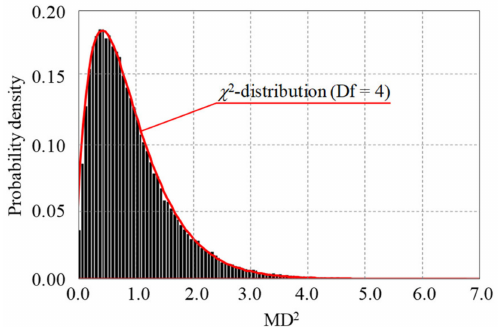
Figure 3. Probability density distribution of calculated results when operating in the normal